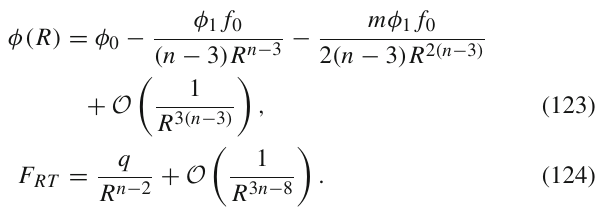
Fig. 1 The Penrose diagram for all the asymptotically flat spacetimes given by the solutions I–IV and V 1 with nontrivial configurations of a scalar field and a Maxwell field. A zigzag line represents a timelike curvature singularity. (cid:11) + ( − ) corresponds to the future (past) null infinity. i + ( − ) corresponds to the future (past) timelike infinity, while i 0 is the spacelike